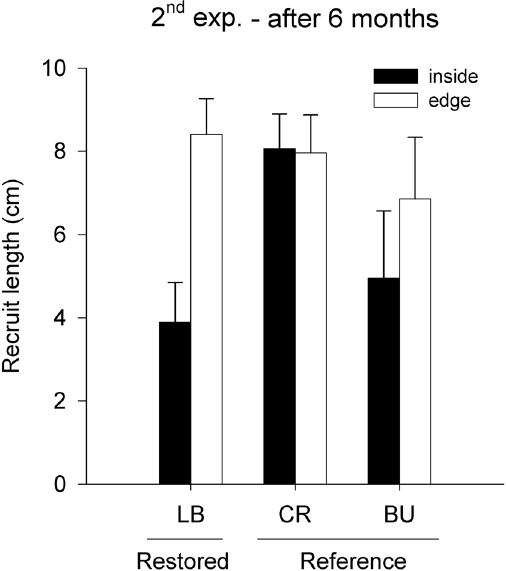
Figure 5. Mean ( ± S.E.) lengths of recruits inside (black bars) or at the edge ( , 30 cm; white bars) of patches of Phyllospora at the restored place Long Bay (LB; n =5) and at reference places (CR, Cronulla, BU, Bundeena; n =10) after 6 months from the start of the second experiment.